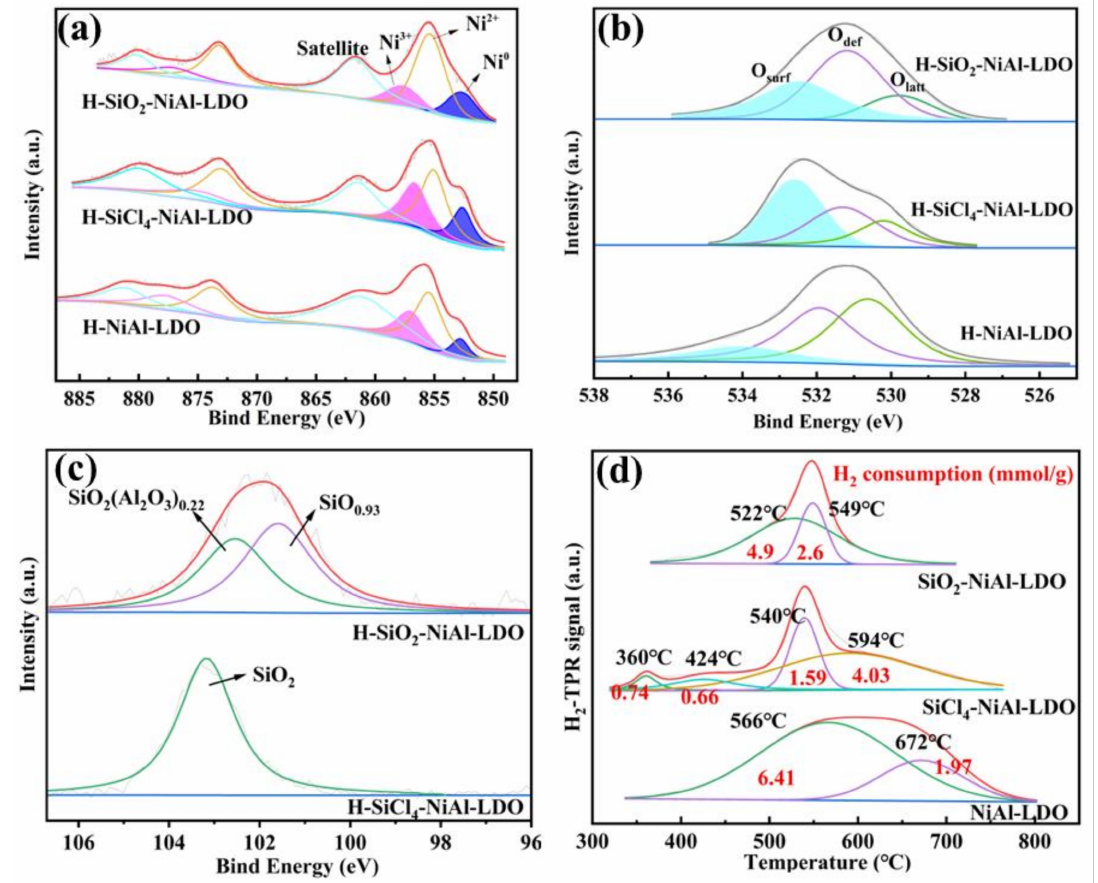
Figure 5. ( a ) Ni 2p XPS spectra, ( b ) O 1s XPS spectra, ( c ) Si 2p XPS spectra and ( d ) H 2 -TPR profiles of